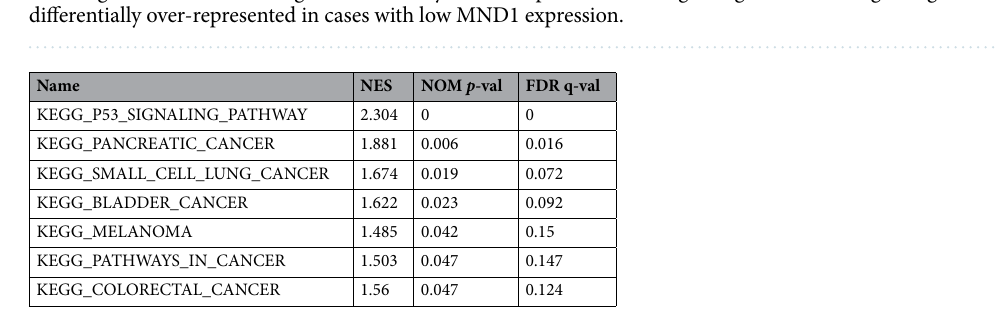
Table 5. Gene sets over-represented in the elevated MND1 expression phenotype.